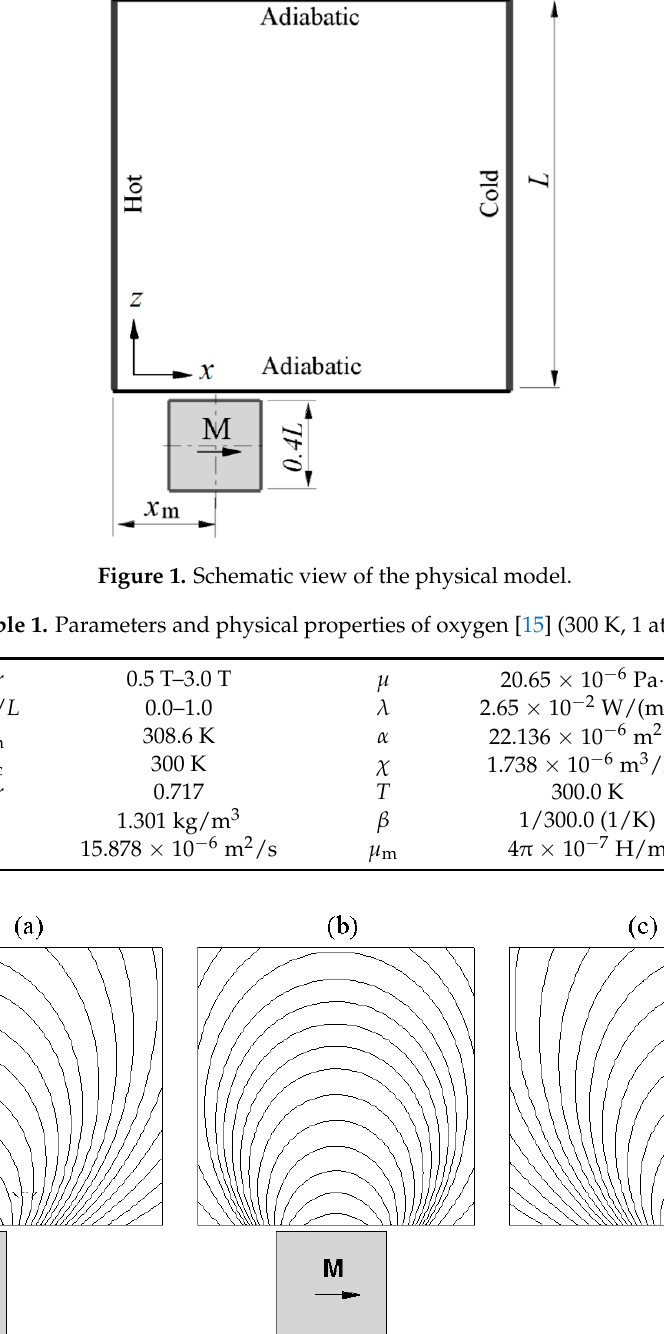
Figure 2. Magnetic field lines in the enclosure for different magnet positions. ( a ) x m / L = 0.2, ( b ) x m / L = 0.5, ( c ) x m / L = 0.8.